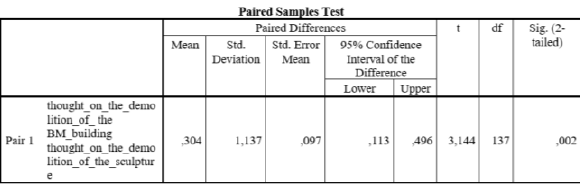
Table 5. Paired Samples test among the participants thought on the demolitions of the Bank of Municipalities Building and Hajek’s